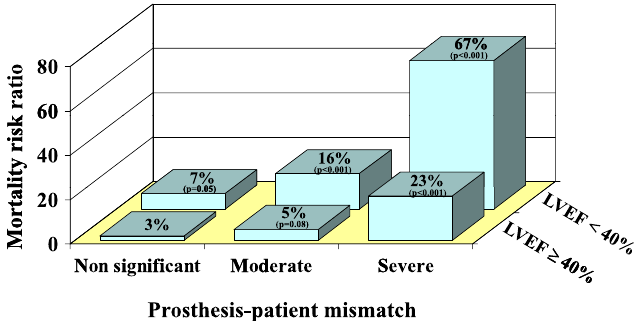
Figure. 6 In-hospital mortality according to patient-prosthesis mismatch and preoperative left ventricular ejection fraction (LVEF). The p values above the bars correspond to the comparison with the group with non- significant mismatch and normal LVEF. (Reproduced and modified with permission from